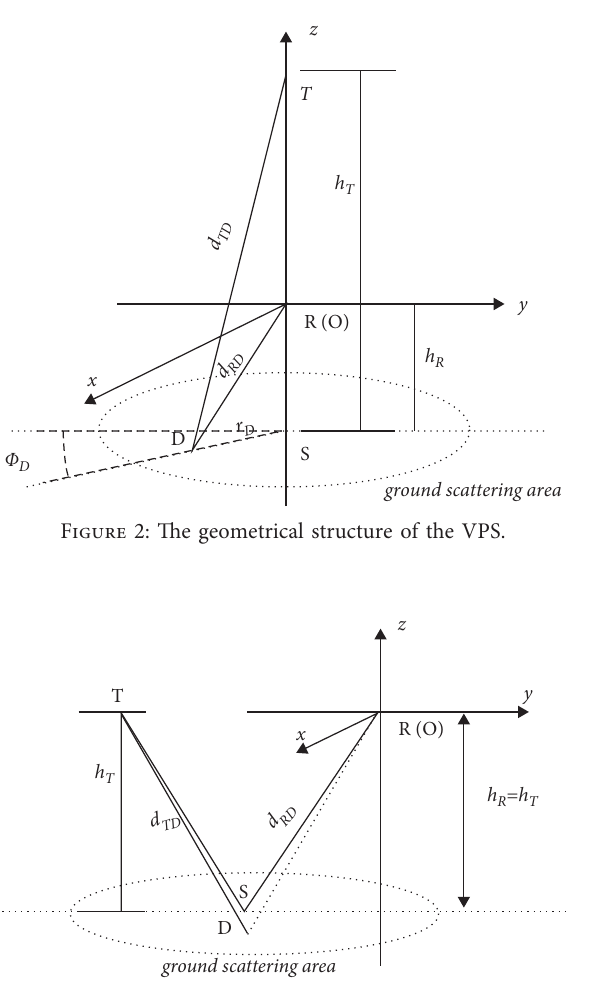
Figure 3: The geometrical structure of the